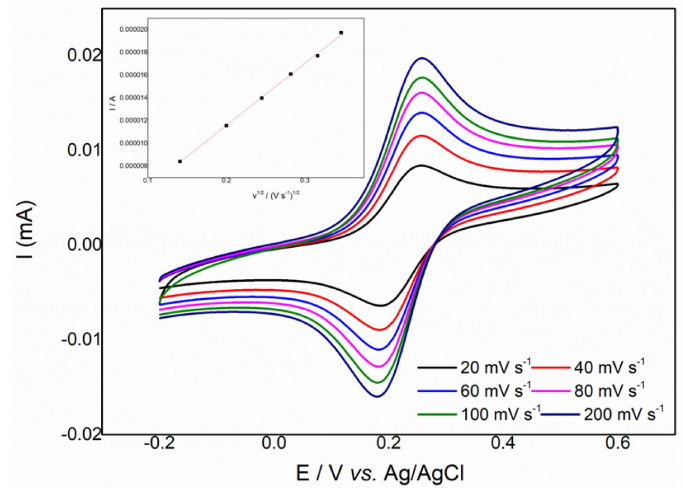
Figure 5. Cyclic voltammetry of the probe solution of ferri-ferrocyanide ions at different scan rates in NaNO 3 0.1 mol L − 1 . Inset: variation of reduction peak current with square root of scan